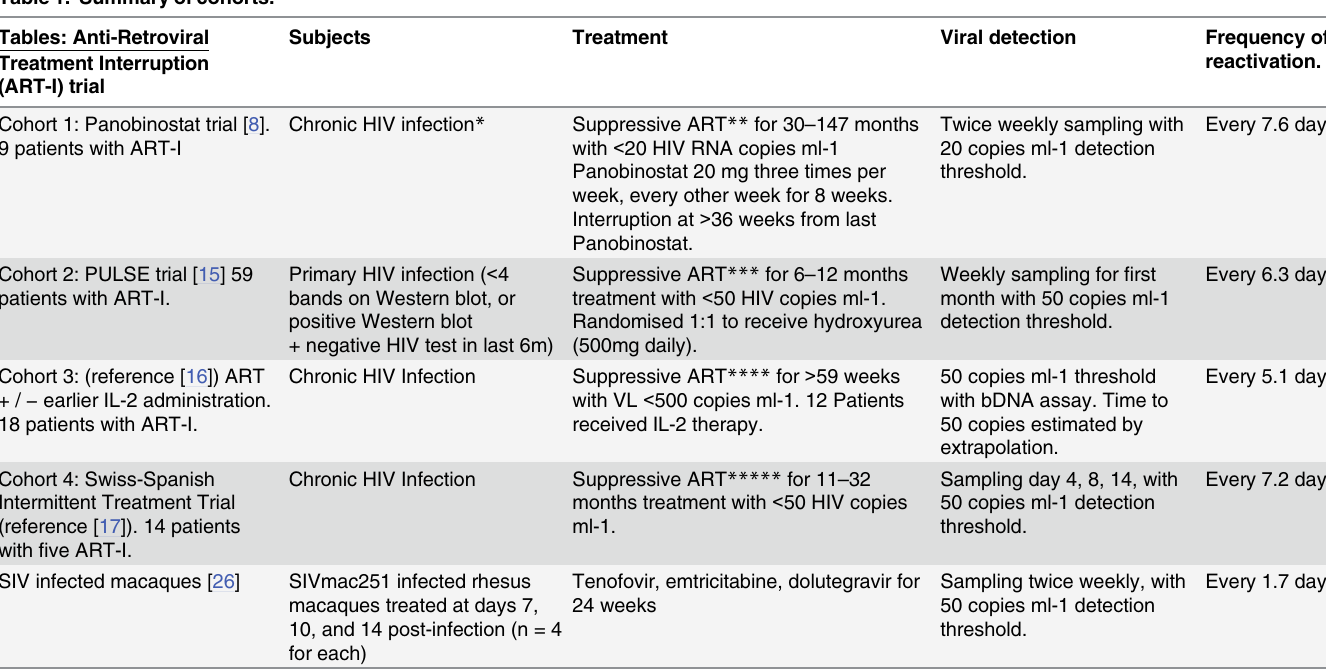
Fig 2. Dynamics on recrudescence in nine patients enrolled in Panobinostat trial (reference [8]). (A) The trajectory of viral load of individual patients after ART-interruption. Dashed line indicates threshold of detection (20 copies ml -1 ) (B) the ‘ survival curve ’ of patients without detectable virus. The frequency of recrudescence is equivalent to one initiation of viral replication occurring every 7.6 days. (C) growth rate of virus after detection is not significantly correlated with time to recrudescence (p = 0.9). doi:10.1371/journal.ppat.1005000.g002 Table 1. Summary of